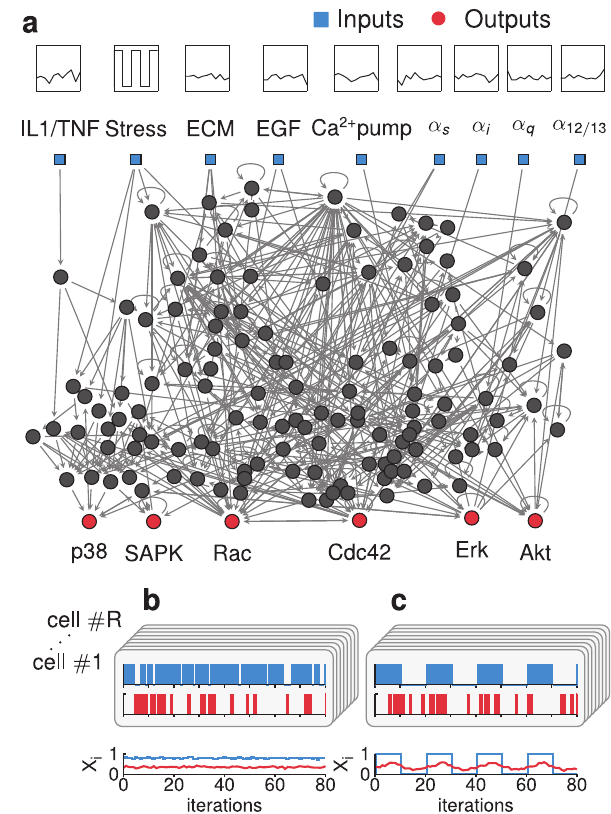
Figure 1. Boolean network model and simulations. (a) The Boolean network model under investigation. The network has 9 input nodes (blue squares at the top row), which we force with periodic or random signals (compare stress to the other inputs, respectively), as pictured schematically above each node, depending on the simulation performed. The network has 130 internal nodes, six of which are considered output nodes (red circles at the bottom row, while the rest of the internal nodes are represented by black circles). (b) Response of the network to a constant chatter level. Here we show a realization of the network dynamics (cell # 1) in which the states of all input nodes randomly switch between 0 and 1 at a chatter level of q ~ 0 : 8 . For clarity, we show the evolution of only one input node (stress, in blue) and one output node (p38, in red). The population average signal for the two nodes, calculated averaging data from R=201 realizations, is shown at the bottom. (c) Response of the network to periodic stimulation of one input node. We show one network realization in which input node stress oscillates (period T 0 ~ 20 ), and the other input nodes are set to chatter level q ~ 0 : 8